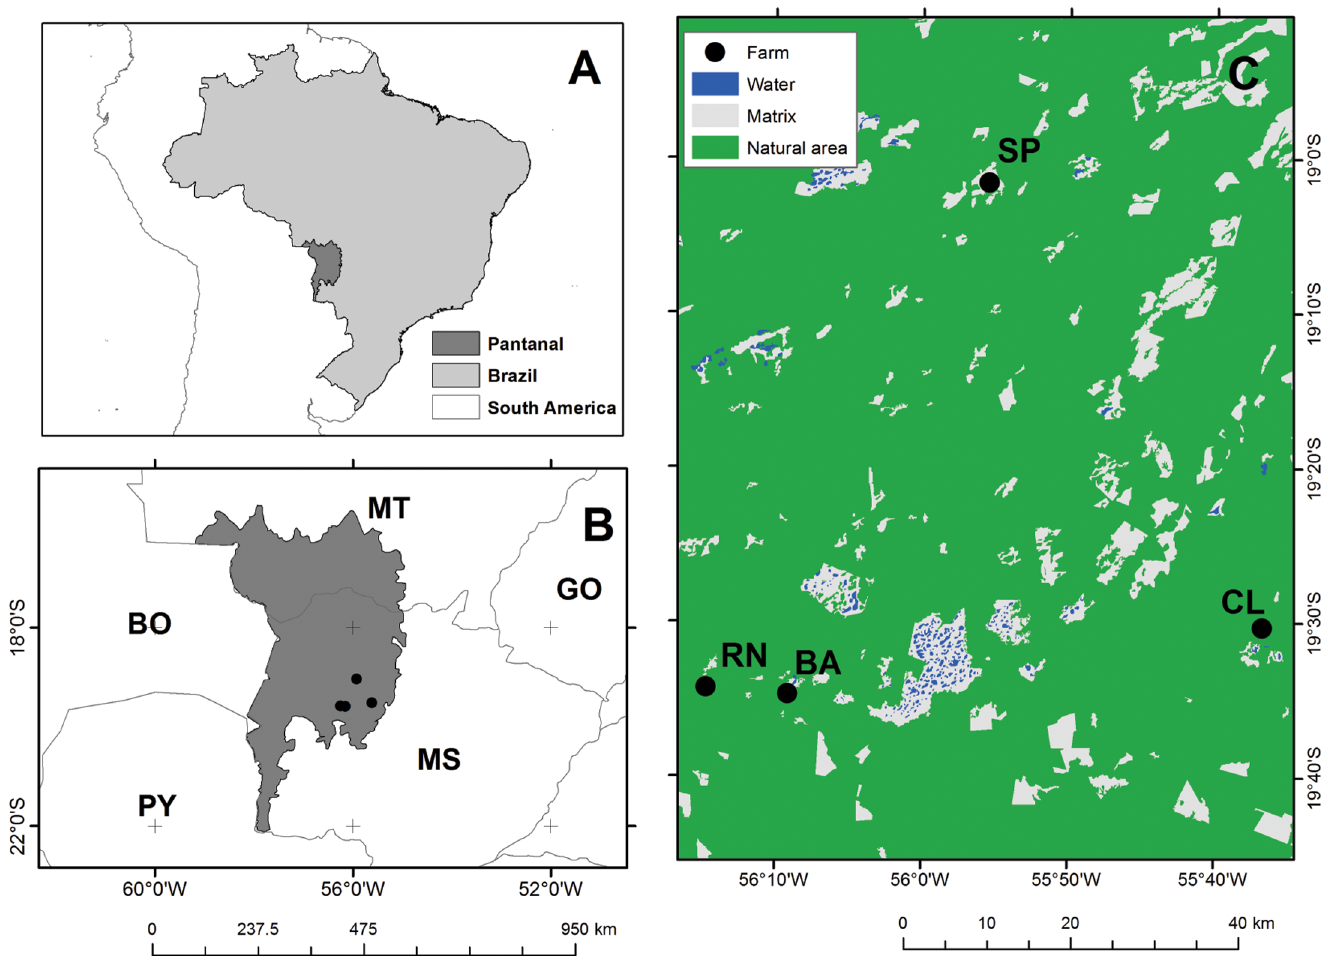
Fig 2. Location of the Brazilian Pantanal and the study sites. Fazenda Rio Negro (RN), Fazenda Barranco Alto (BA), Campo Lourdes (CL) and S ã o Paulino (SP).